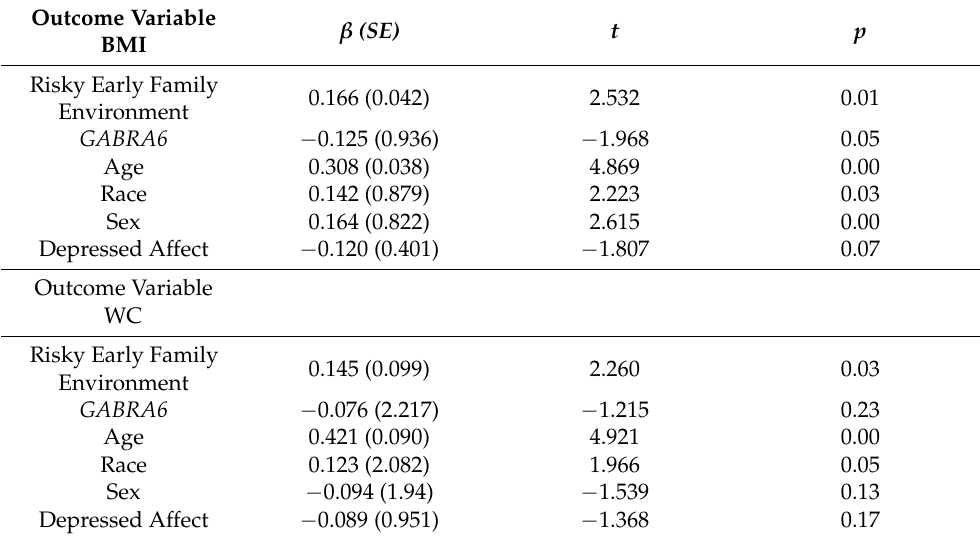
Table 3. Summary of multiple regression analysis with both a risky family environment and GABRA6 .